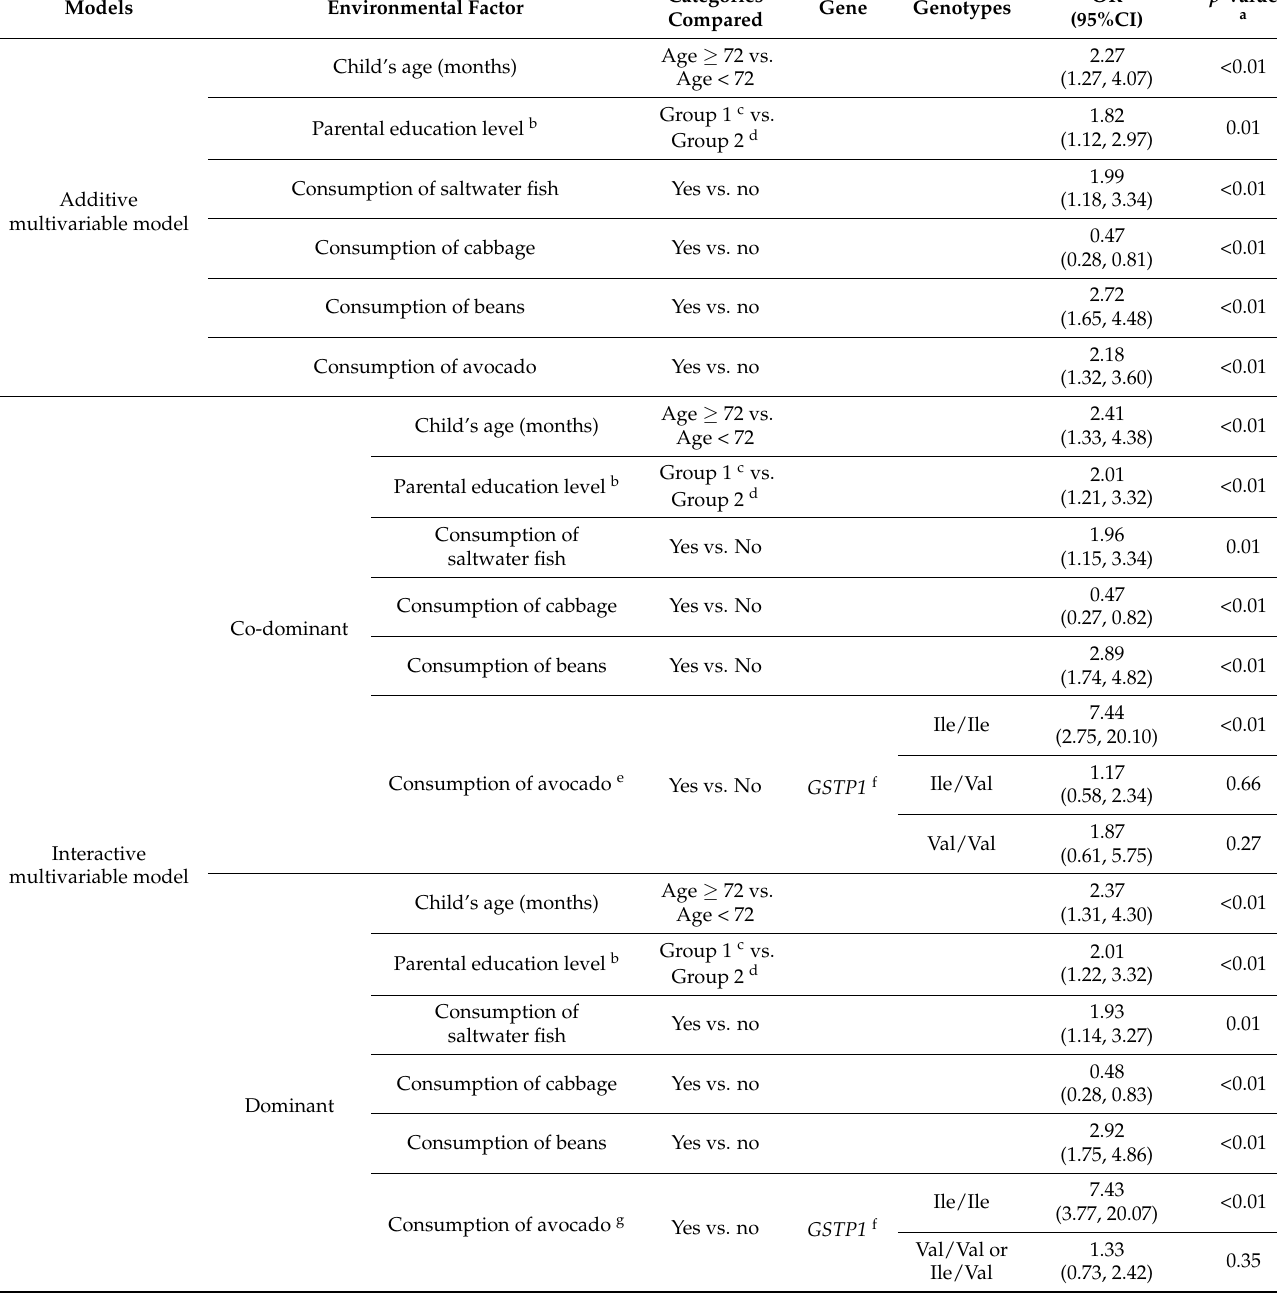
Table 4. Adjusted associations between children’s exposure to environmental factors and a binary detectable level of blood As concentrations by children’s genotypes for GST genes based on mul- tivariable logistic regression models that include the interaction between GST genes and the main environmental exposure ( n =